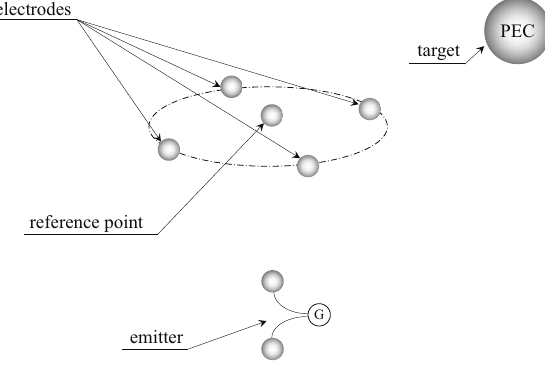
Figure 11. The simulation model schematic diagram implemented by using CST. PEC, perfect electric